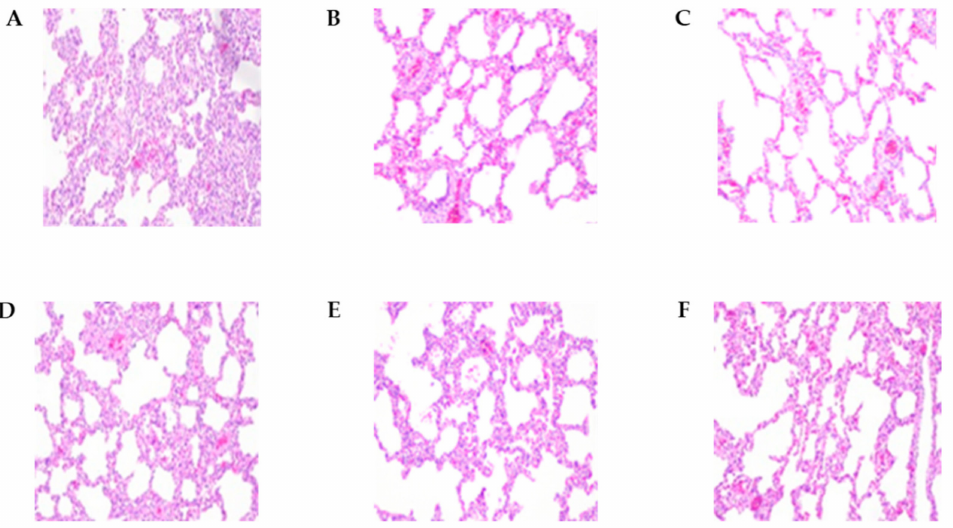
Figure 4. The histopathological lesions of necropsied pig lungs at 2 wpi and 4 wpi. ( A ) E38 original virus group lung lesions 2 weeks post-inoculation (wpi). ( B ) E38-ORF7 CPD group lung lesions 2 wpi. ( C ) Control group lung lesions 2 wpi. ( D ) E38 original virus group lung lesions 4 wpi. ( E ) E38-ORF7 CPD group lung lesions 4 wpi. ( F ) Control group lung lesions 4